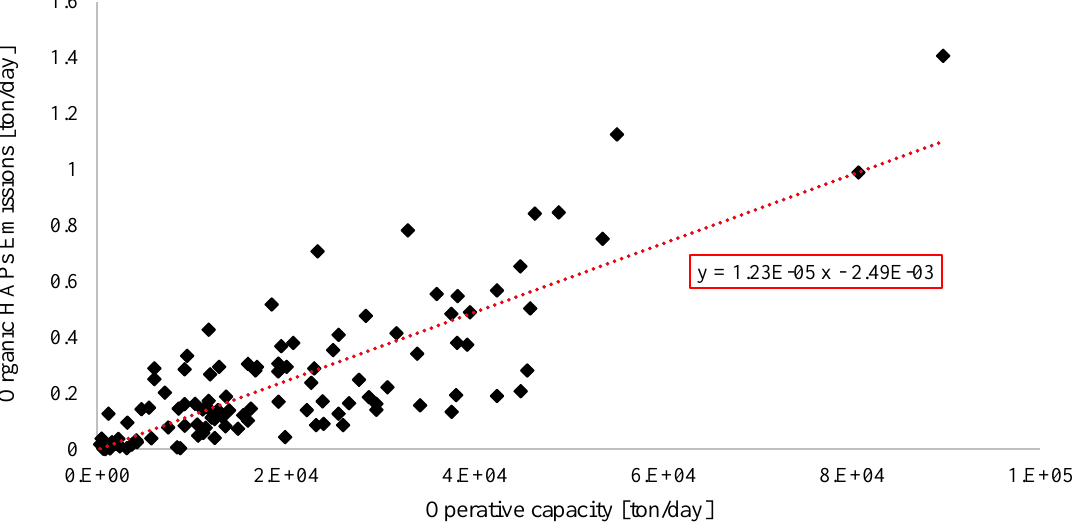
Figure 2. Total emissions of organic HAPs for 109 refineries.